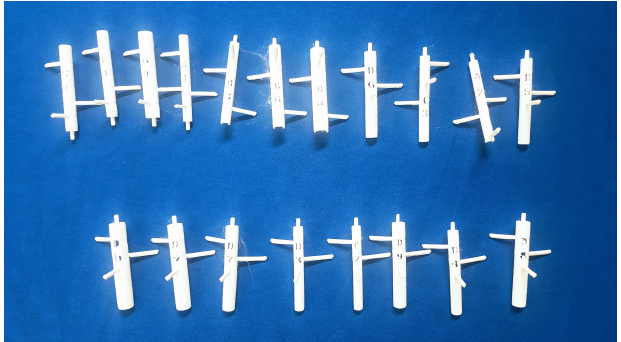
Figure 9. Marker tools. We used an inexpensive 3D printer to create marker tools with various sizes and